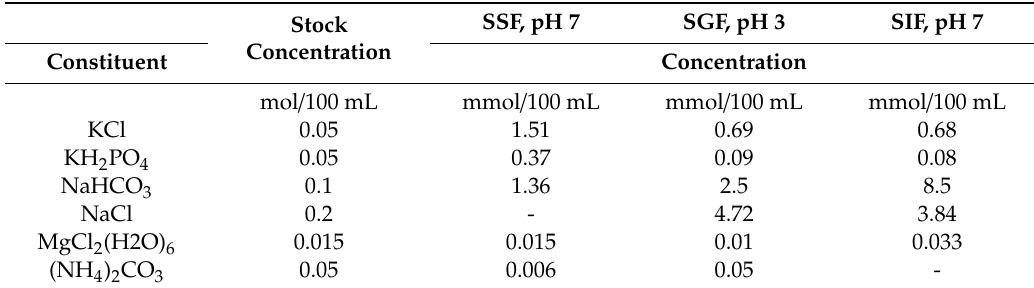
Table 1. Preparation of the simulated fluid stock solution. SSF, pH Stock Concentration